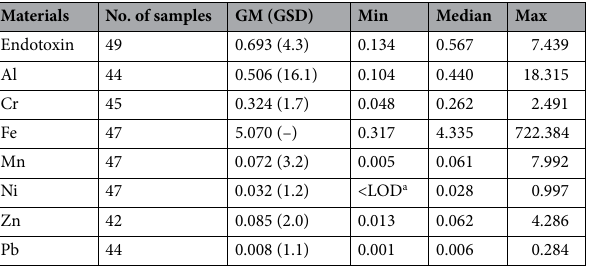
Table 2. Overall levels of airborne endotoxin (unit: EU/m 3 ) and heavy metals (Al, Cr, Fe, Mn, Ni, Zn, and Pb) (unit: µg/m 3 ) in subway environments. a Limit of detection.